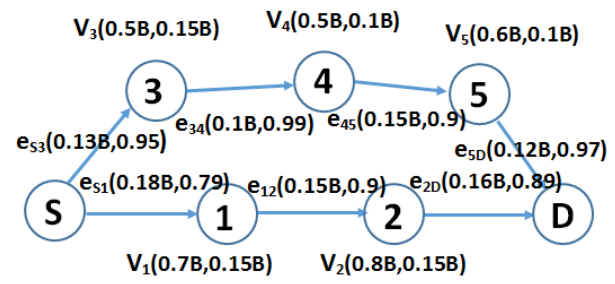
Figure 2. The sample network illustrates the benefit of a stability-aware routing scheme for minimizing energy consumption and reliable data transmission in energy harvesting wireless sensor networks